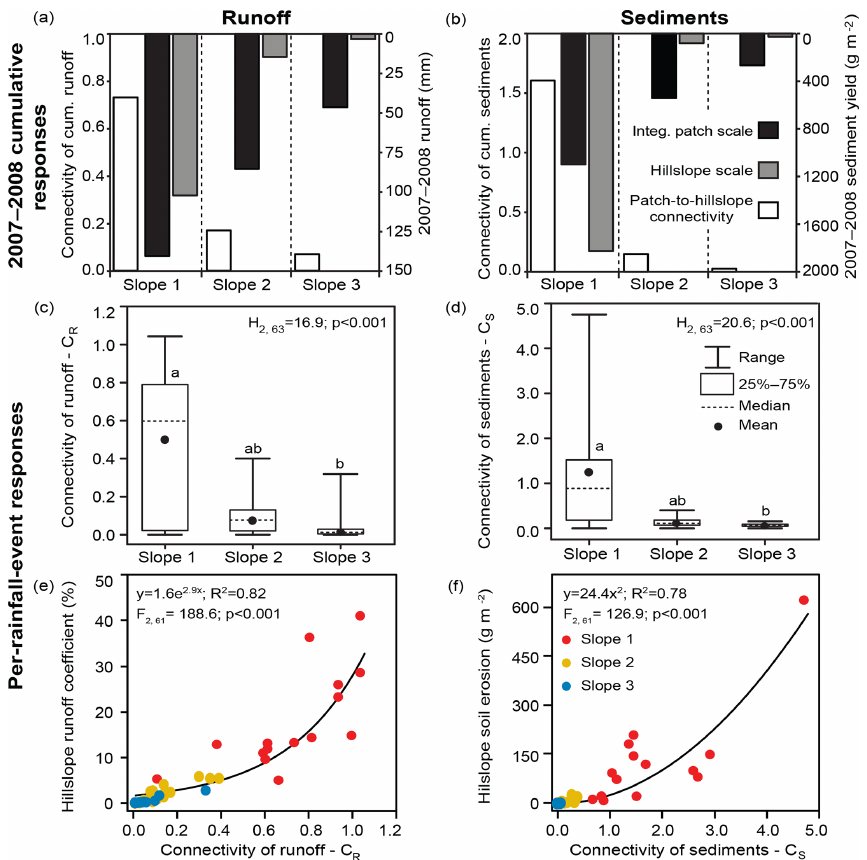
Figure 4. Functional connectivity: (a, b) 2007–2008 cumulative and (c, d) per-rainfall-event connectivity of (a, c) runoff ( C R ) and (b, d) sed- iments ( C S ) in the experimental slopes; (e, f) relationship between the (per-rainfall-event) connectivity of runoff and sediments and the hillslope-scale runoff coefficient and soil erosion. Connectivity of runoff and sediments across scales is represented as the ratio of hillslope- scale to patch-scale runoff and sediments (white bars). Runoff and sediment yield at both the hillslope scale (grey bars) and the integrated (i.e. area-weighed) patch scale (black bars) are provided for the 2007–2008 cumulative metrics (secondary vertical axis of graphs in panels a and b ). Different letters in bars of the graphs in panels (c) and (d) indicate significant differences for the three slopes at α = 0 . 05. Tested using Kruskal–Wallis ANOVA ( H statistics and p levels are shown in the